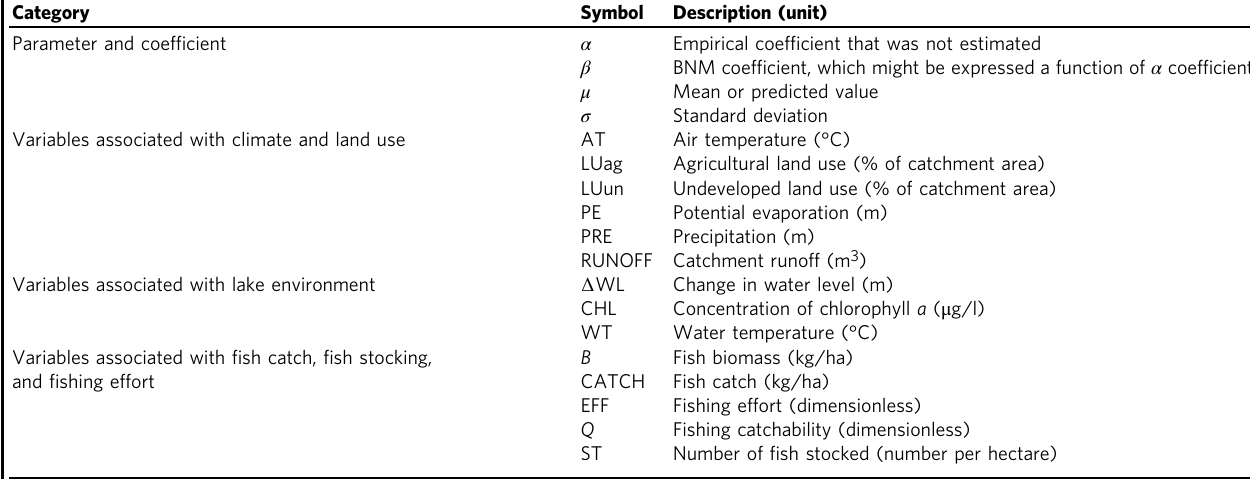
BNM Bayesian networks model.